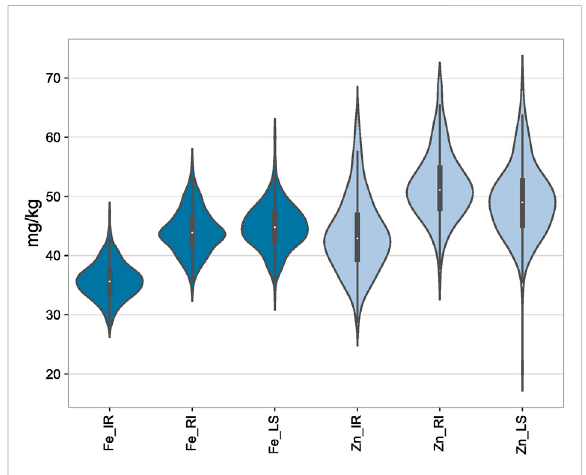
FIGURE 1 Depiction of the distribution of GFeC and GZnC under IR, RI, and LS conditions through violin